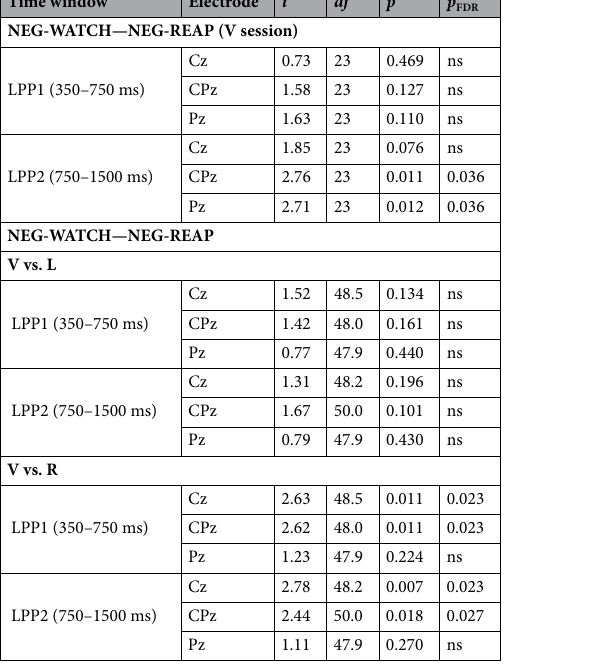
Table 1. Statistics for the LPP